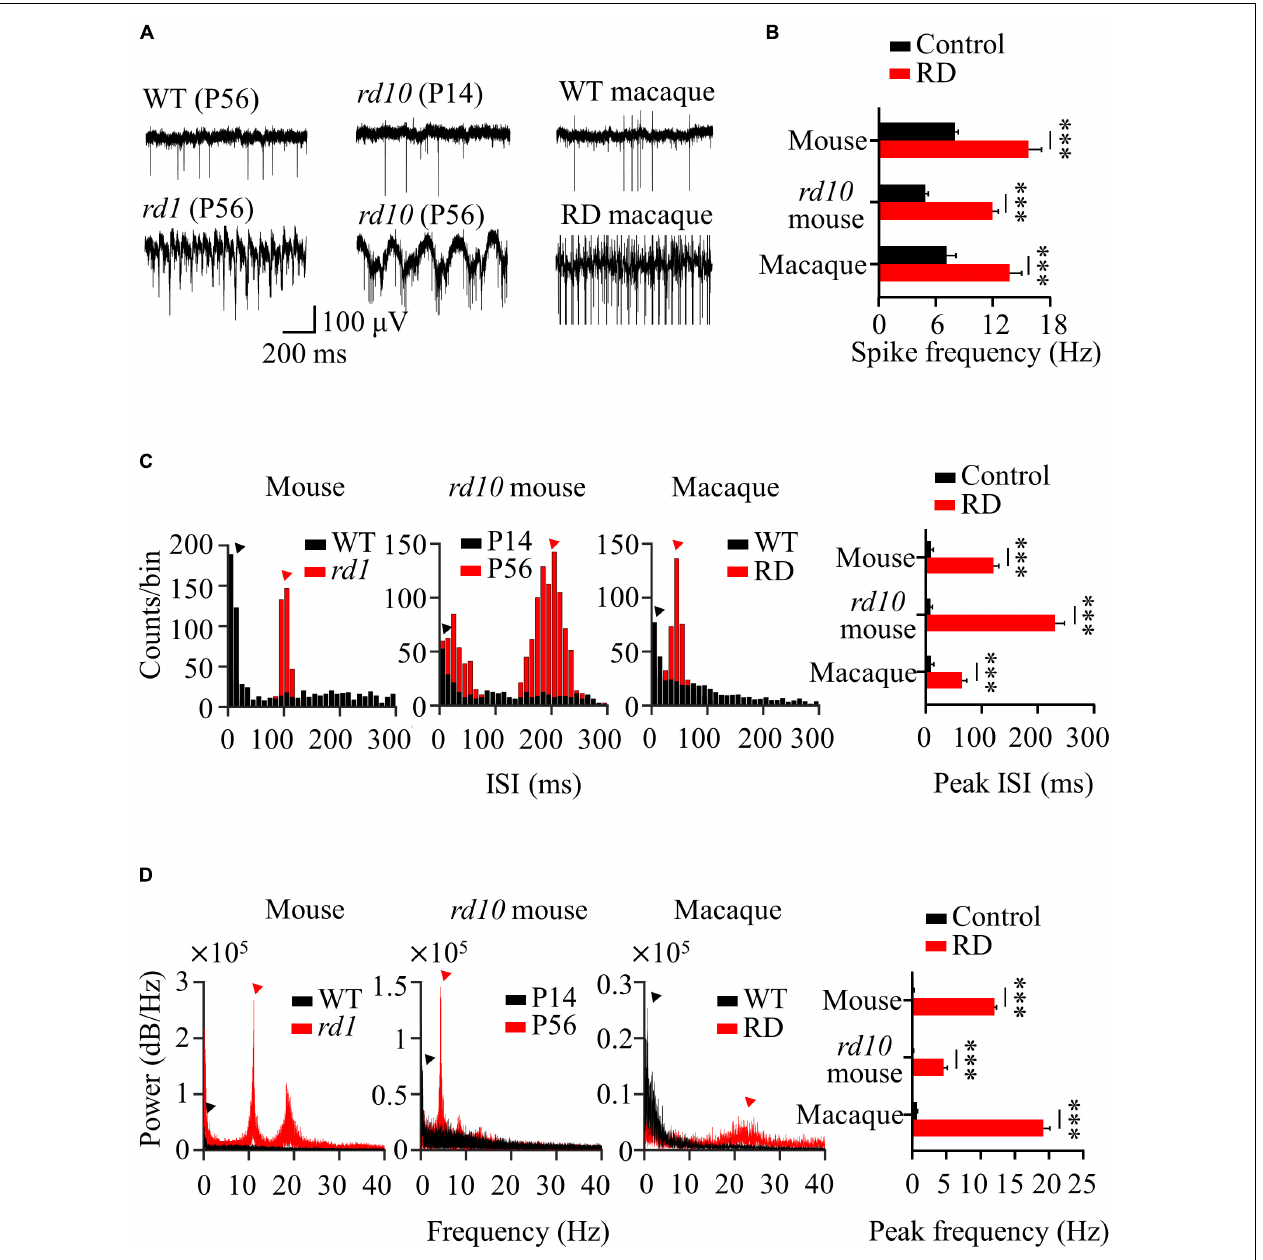
FIGURE 1 | Spontaneous activity of RGCs in normal and degenerate retinas. (A) Representative raw traces of RGCs observed in control (WT P56, rd10 P14, WT macaque) and RD groups ( rd1 P56, rd10 P56, RD macaque). (B) Spike frequency of RGCs for control and RD groups. (C) Inter-spike interval histogram. Red and black arrowheads indicate the main ISI peaks for each RD and control group. (D) Power spectral density using FFT for detection of the dominant LFP frequency. Statistically significant differences between each of the different groups are shown above (*** p <